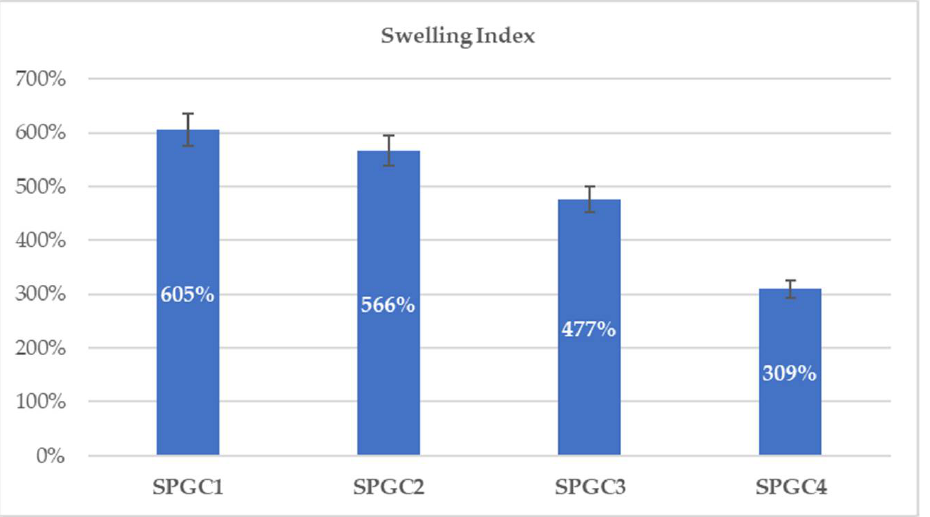
Figure 3. The effects of different citric acid concentrations on starch-based materials swelling index.